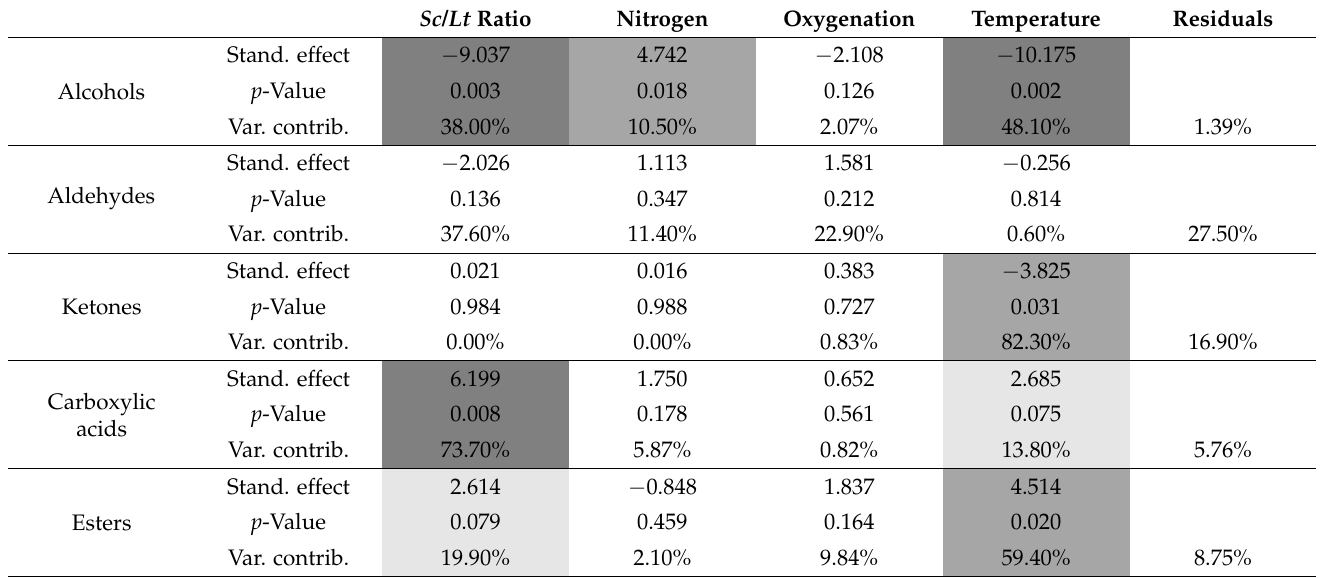
Table 5. Impact of fermentation parameters on the production of volatile compounds.